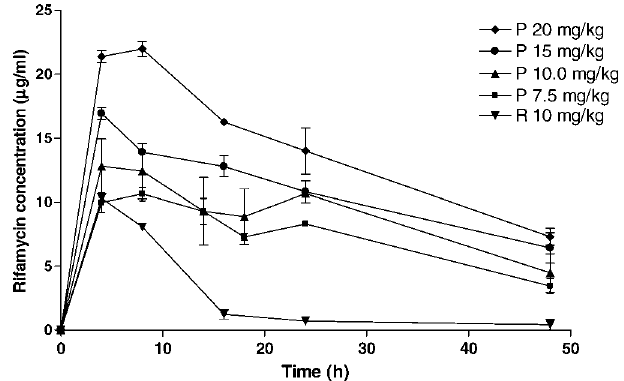
Figure 3. Mean Rifapentine and Rifampin Serum Concentrations versus Time Mice were administered a single dose of 7.5, 10, 15, and 20 mg/kg of rifapentine or 10 mg/kg of rifampin. P, rifapentine; R,